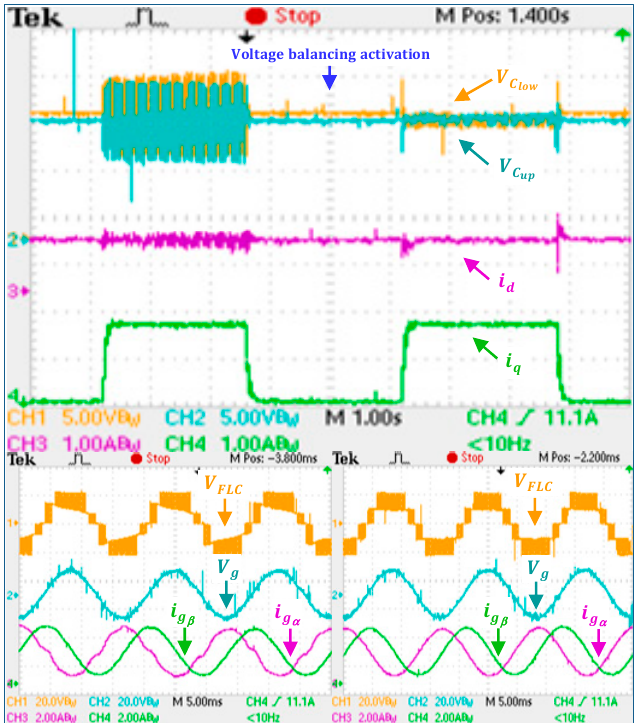
Figure 13. Performance of the voltage balancing strategy and the vector control for the proposed grid-tied SPFLC during a step-change in the q axis grid